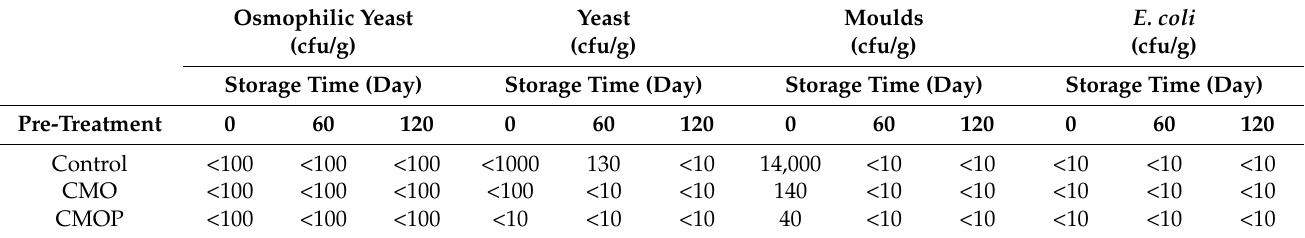
Table 6. Microbial count of untreated and pre-treated dried apple slices overtime # .